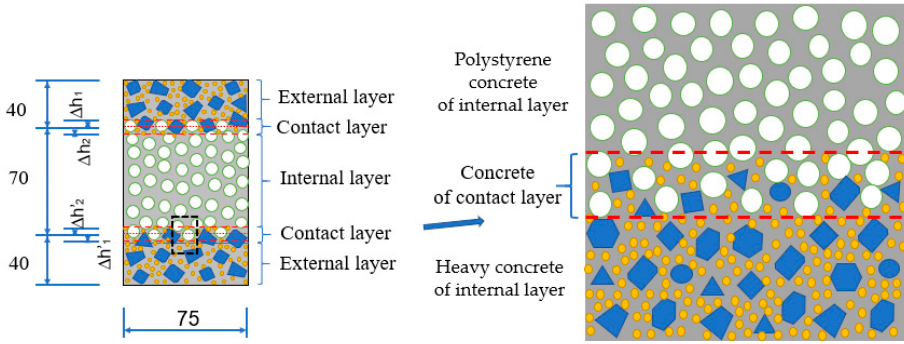
Figure 11. Bonding of the contact zone of layers of multilayer reinforced concrete